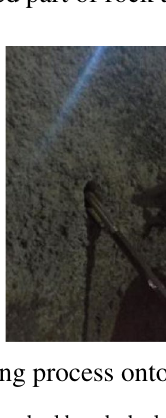
Figure 2. Notched borehole drilling process at rock anchor beam on site.